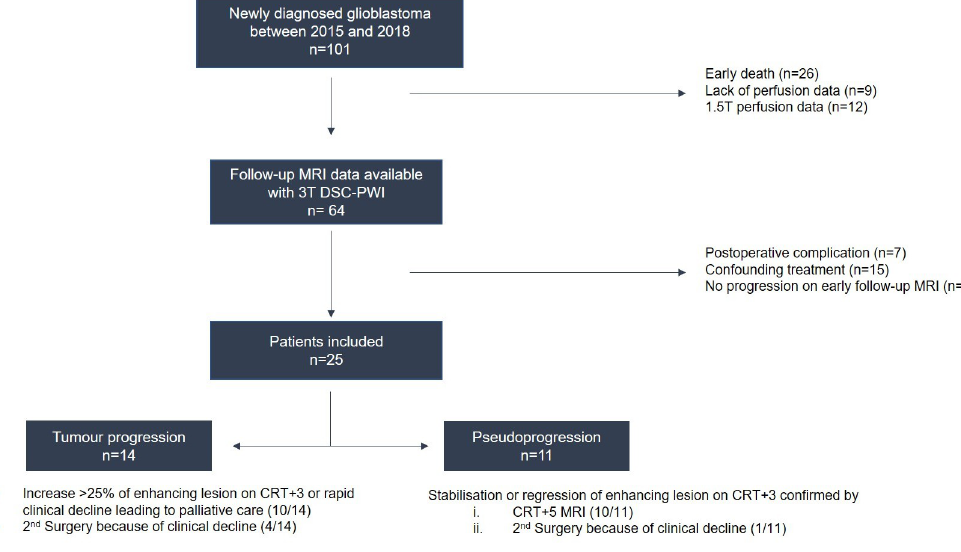
Fig 1. Flow-chart. Twenty-five patients with pathologically proven primary glioblastoma, with at least 4 MRIs and usable perfusion data acquired on 3T systems, treated by chemoradiotherapy showing progressive lesion enhancement on early follow-up MRI (CRT+1) were